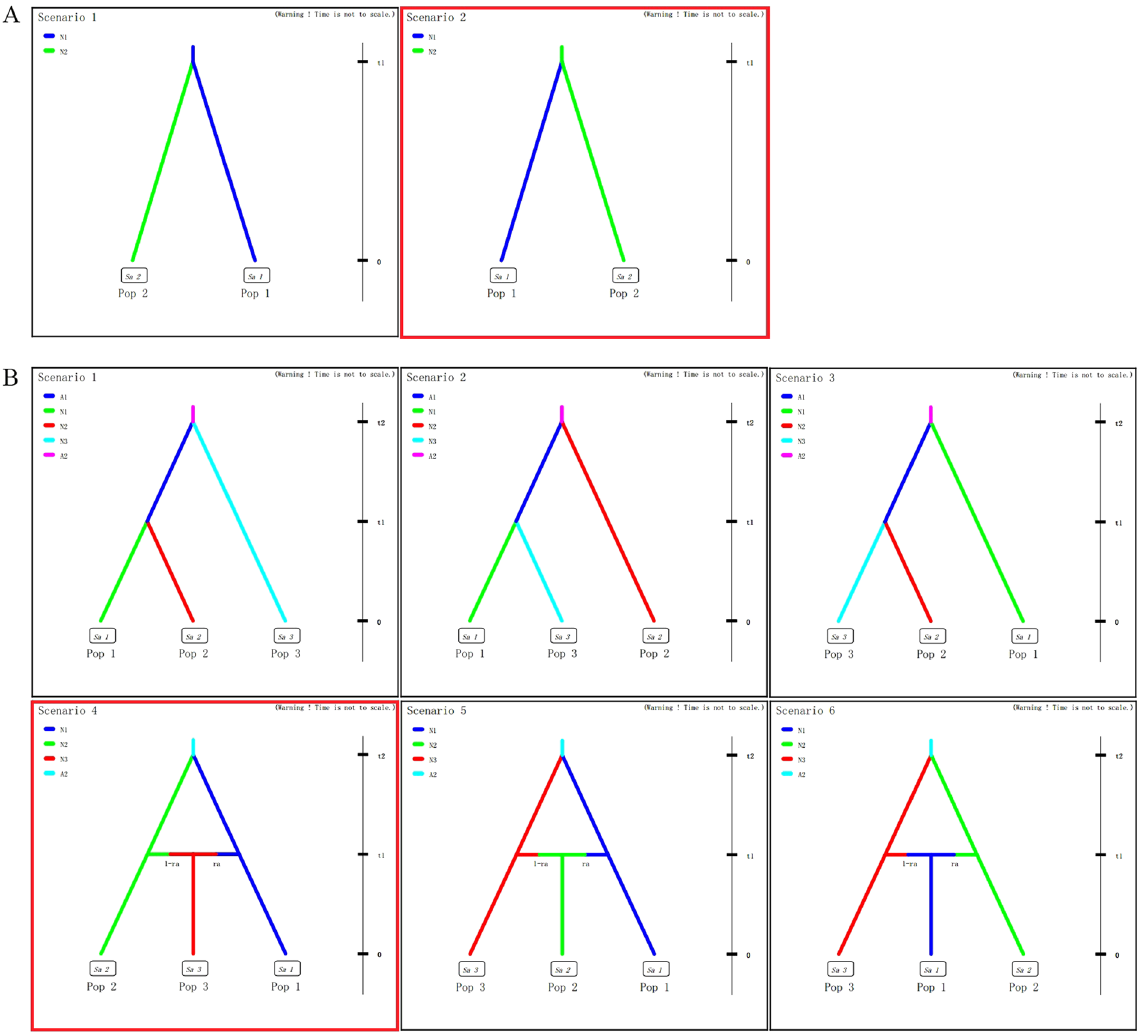
Figure 6. Scenarios for the DIY ABC analyses, which was designed to infer the origin and dispersal of C. ciliata . ( A ) Two scenarios showing the origin of C. ciliata . ( B ) Six scenarios showing relationships of three groups (G2, G3 and G4); regarding the variation in population size and the split and admixture events. The best scenario in the corresponding step was indicated by red square.